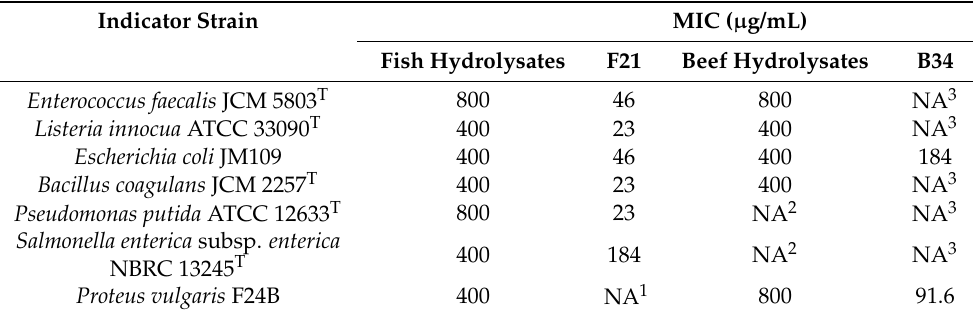
JCM, Japan Collection of Microorganisms (Wako, Japan); ATCC, American Type Culture Collection (Manassas, VA, USA); NBRC, National Institute of Technology and Evaluation (NITE) Biological Resource Center